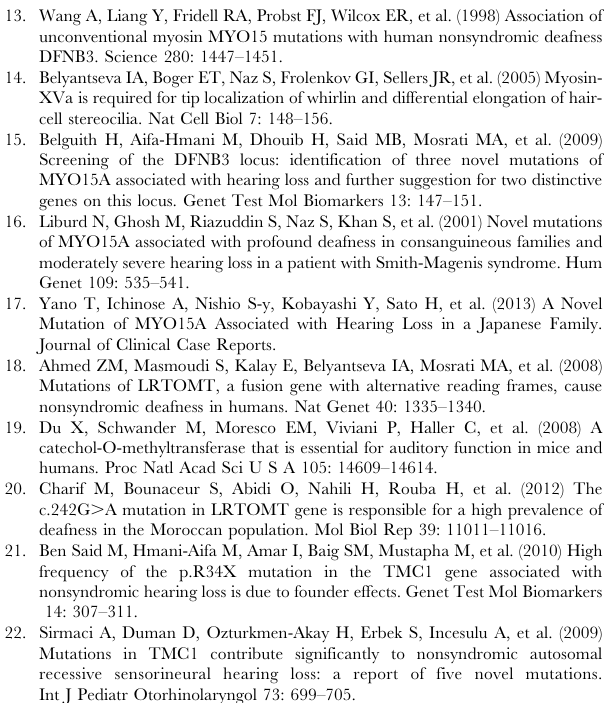
Table S1 List of the mutations excluded by Sanger sequencing in ascertained families before whole exome sequencing. Table S2 List of the mutations retained after the 5 filtering